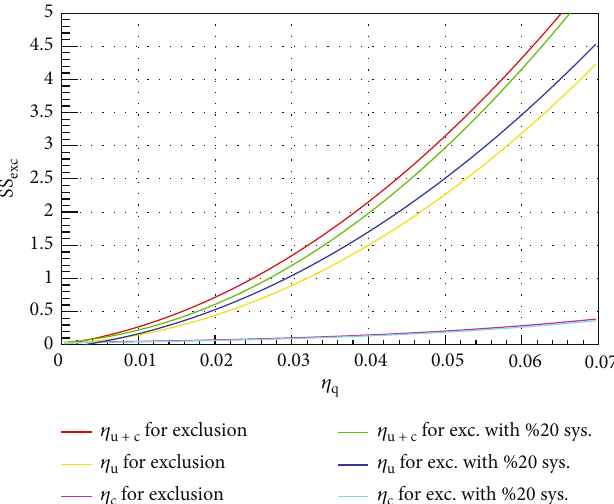
Figure 22: Signal signi fi cance ( SS ) versus η -coupling parameter for three di ff erent scenarios at 3 ab − 1 -integrated exc q Table 5: Upper limits on η parameter and corresponding branching ratio as a potential discovery scenario projection at HL-LHC with no q systematics (left side) and with 20% systematics (right side) at 3 ab − 1 integrated luminosity. Scenario SS disc ≥ 2 20% sys. SS disc ≥ 2